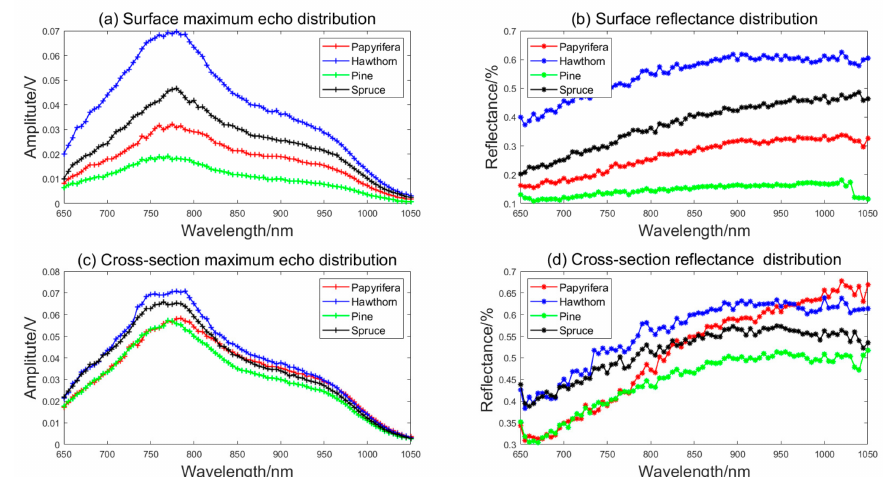
Figure 8. Echo and reflectance of di ff erent species of timber frame from the same 100-year old building. ( a ) Surface maximum echo distribution. ( b ) Surface reflectance distribution. ( c ) Cross section maximum echo distribution. ( d ) Cross section reflectance distribution.